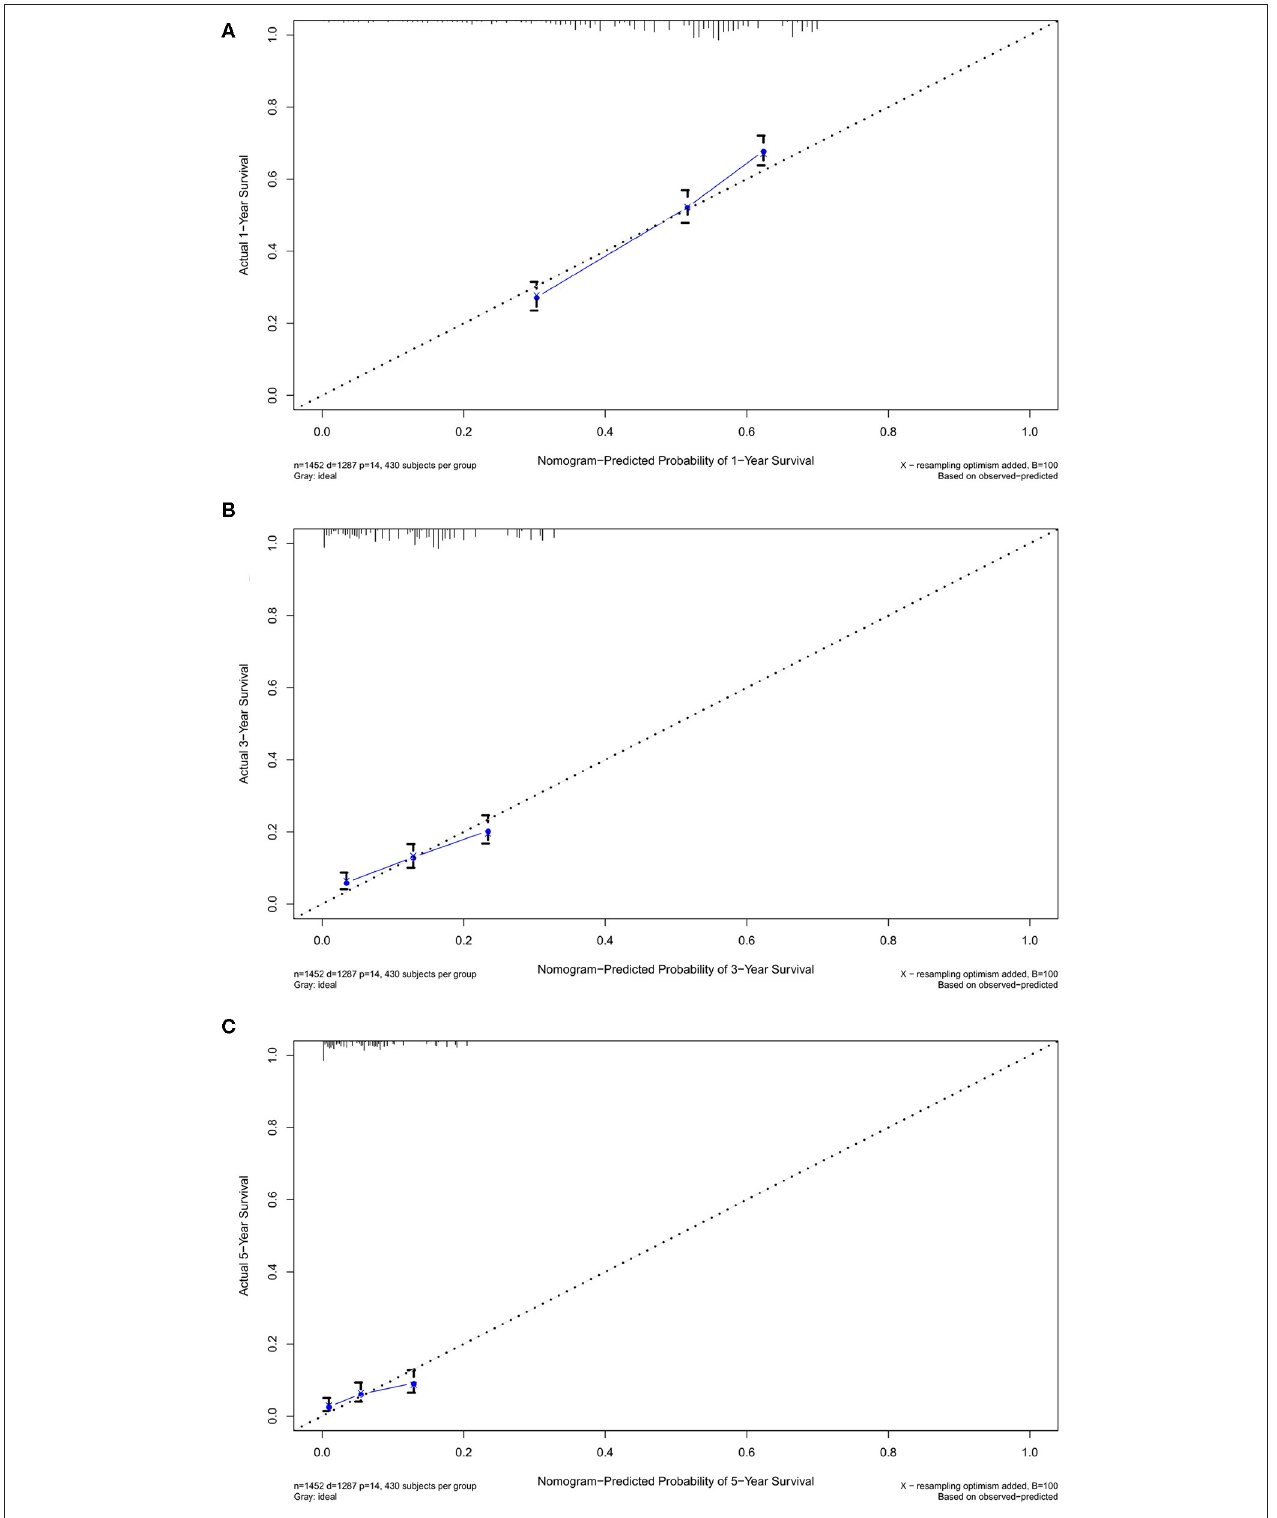
FIGURE 6 | The calibration curves in verification cohort. The calibration curves of the nomogram predicting (A) 1-year, (B) 3-years, and (C) 5-years OS.